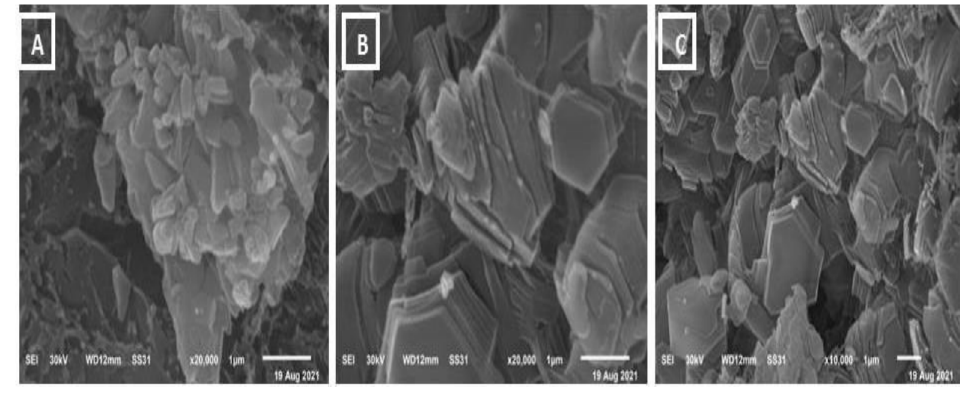
Figure 4. SEM of Ammonium Molybdate ( A – C ).